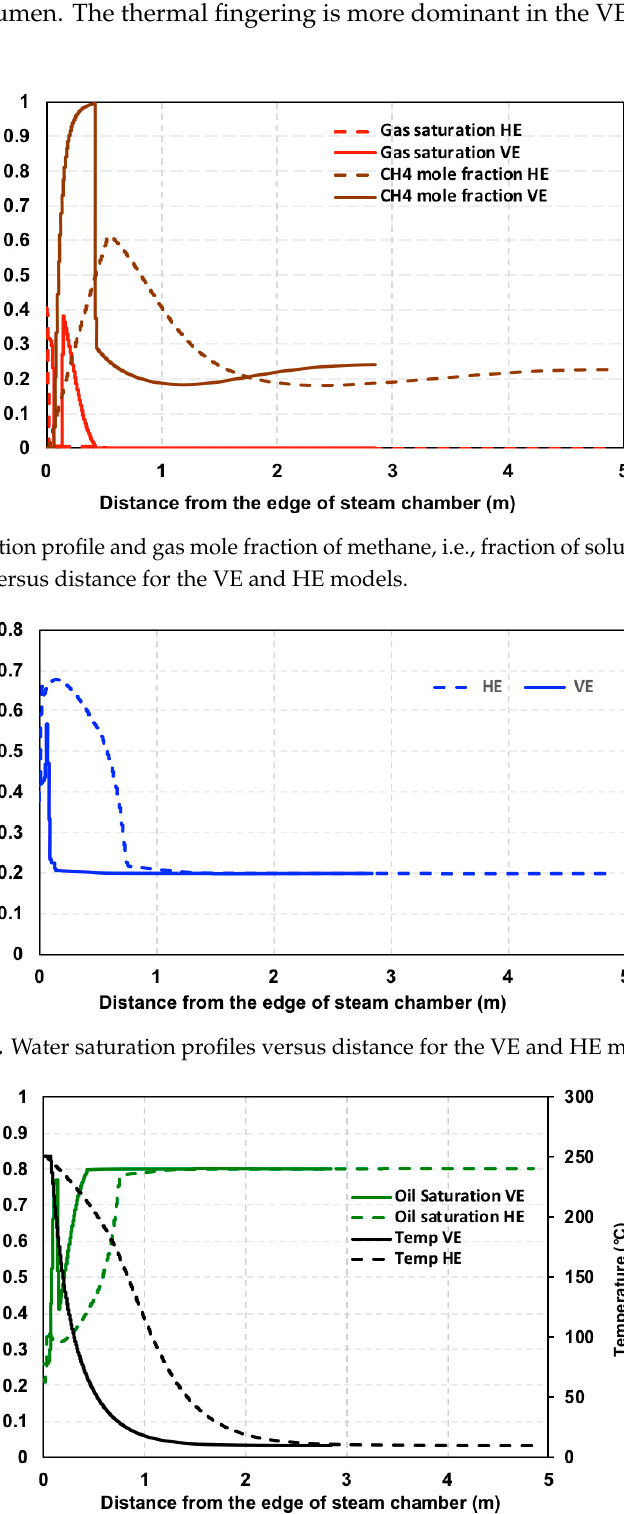
Figure 7. Oil saturation and temperature profiles versus distance for the VE and HE models.